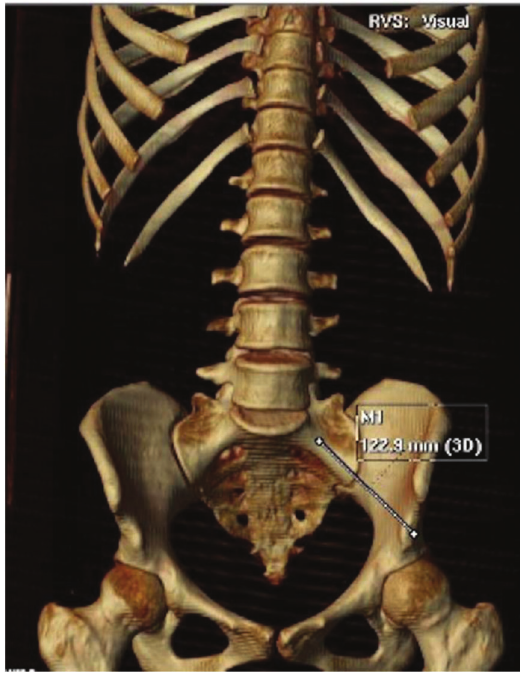
Figure 5 - Example of S2AI screw length on CT 3D (shown by white line).